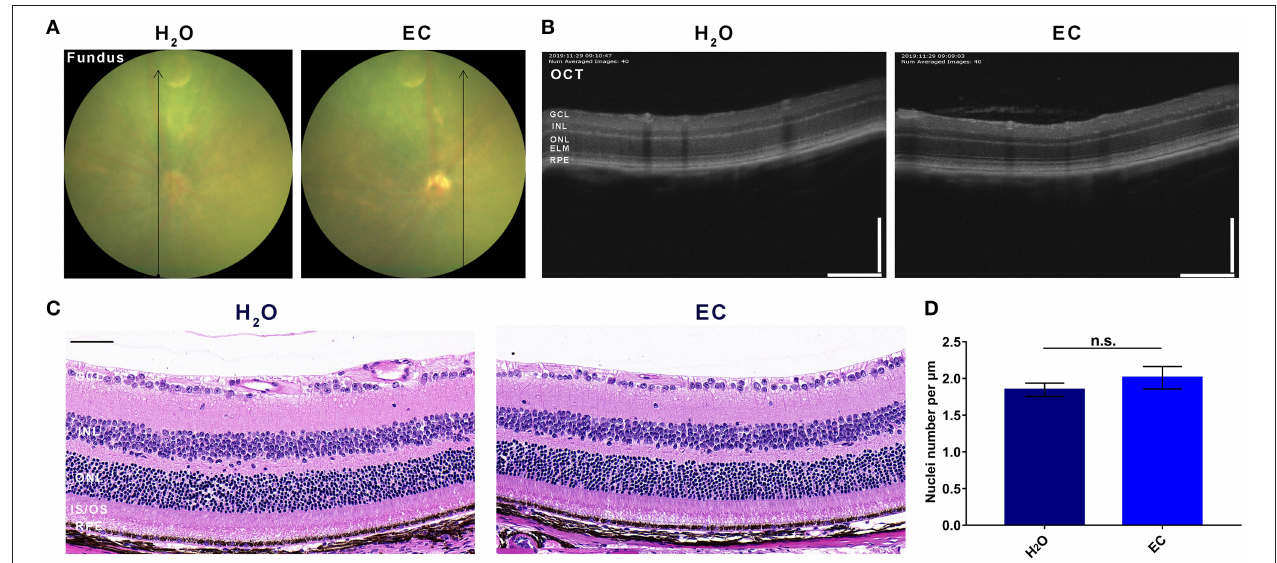
FIGURE 1 | Safety validation of EC on the retina of C57BL/6 mice. Representative images of (A) fundus photography, (B) OCT, and (C) HE stained sections show no lesions in the EC group, and there is no observable structural change between the two groups. (D) Quantification of the number of nuclei per µ m in the ONL. GCL, Ganglion cell layer; INL, inner nuclear layer; ONL, outer nuclear layer; ELM, external limiting membrane; IS/OS, inner segment/outer segment; RPE, retinal pigment epithelium. Values are presented as the mean with SEM, n = 3; n.s., no significance. Scale bar: 50 µ